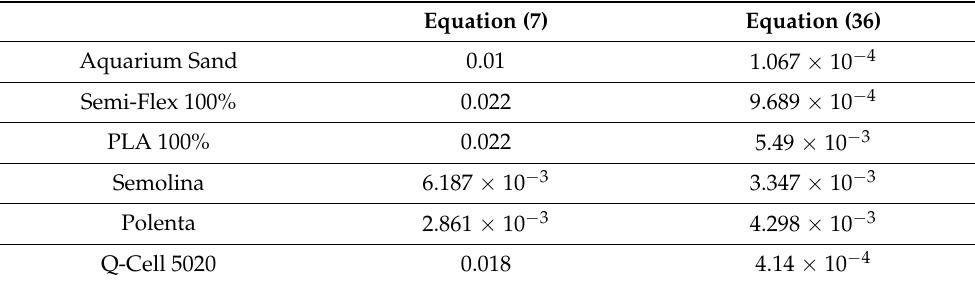
Table 3. Comparison of the uncertainty ∆ ε (cid:48) r from the new approach definition when using the Equations (7) and